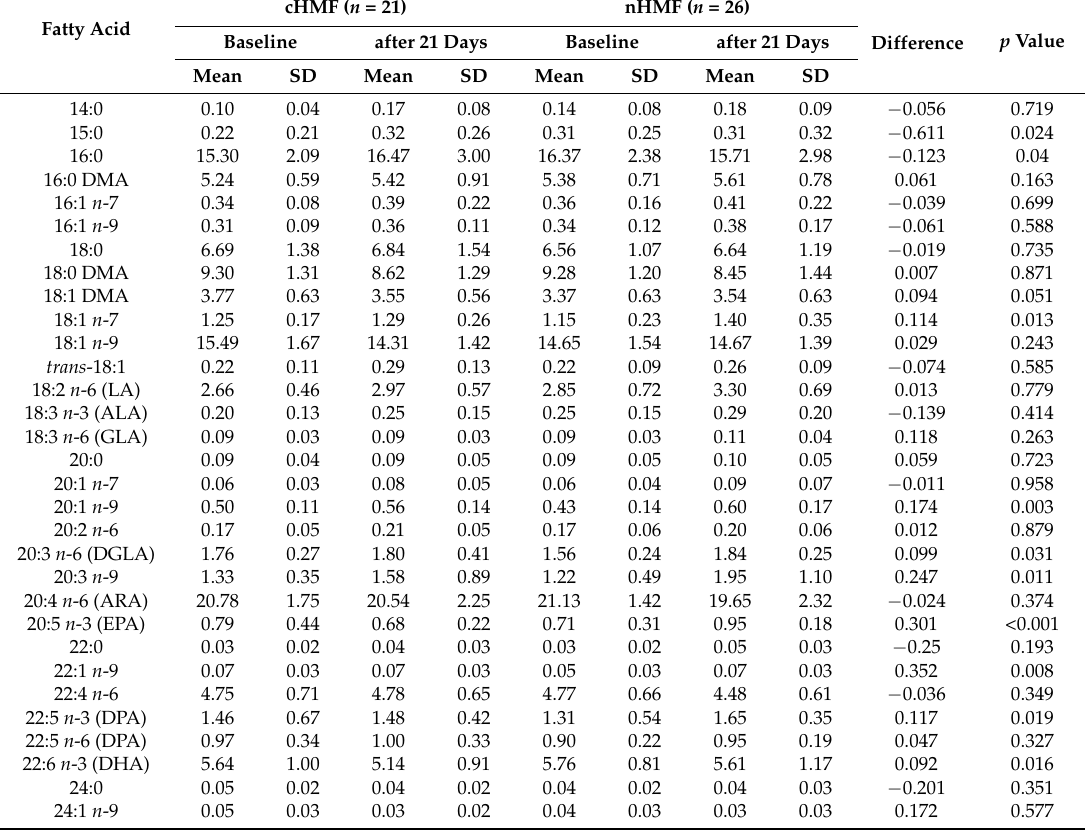
Table 7. Fatty acid profile (g/100 g of fatty acids) of red blood cell phosphatidylethanolamine (RBC PE) in preterm infants receiving human milk fortified with a control (cHMF) or with a new human milk fortifier (nHMF), before and after 21 days of treatment. Estimations of the treatment effect nHMF/cHMF (Difference) and the two-sided p -value are given for each fatty acid analysed in the different lipid